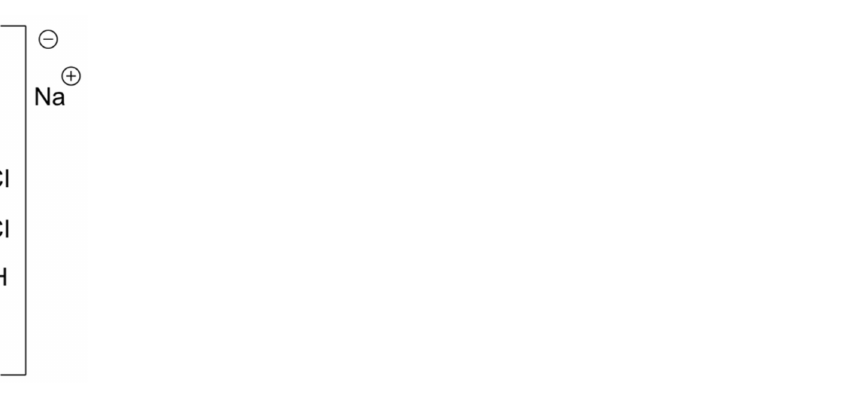
Figure 29. Chemical structure of BOLD-100 (sodium trans-[tetrachlorobis(1H-indazole)ruthenate(III)],